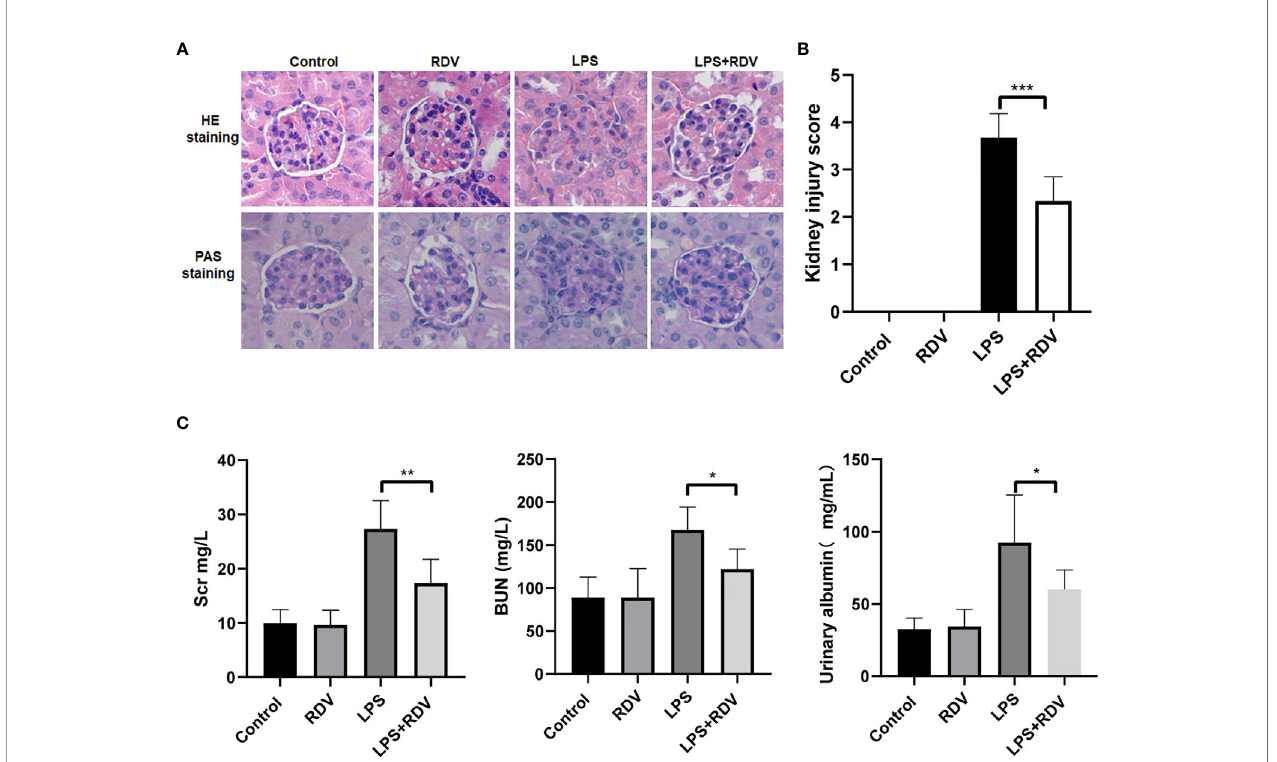
FIGURE 4 | RDV alleviates LPS-induced AKI. (A) HE and PAS staining of kidney tissue sections. (B) Right panel showing the renal in fl ammation score based on HE staining. (C) SCr, BUN and urinary albumin levels detected by ELISA. Data are representative as mean values ± SD from three independent experiments. *P < 0.05; **P < 0.01; ***P <